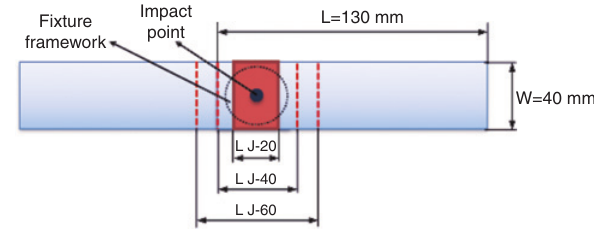
Figure 1 The composite single-lap